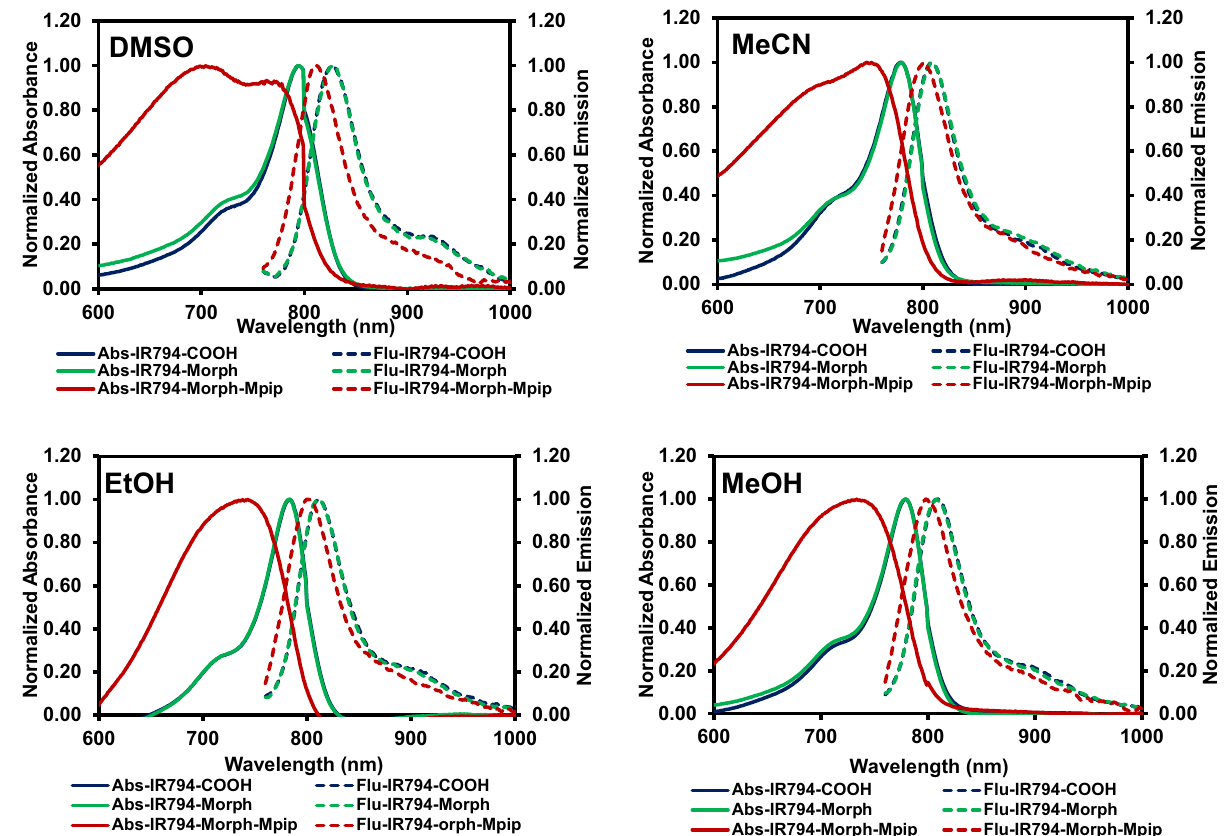
Figure 2. Vis–NIR absorption and fluorescent spectra of IR794 derivatives (1 µM) excited at 750 nm in DMSO, MeCN, EtOH and